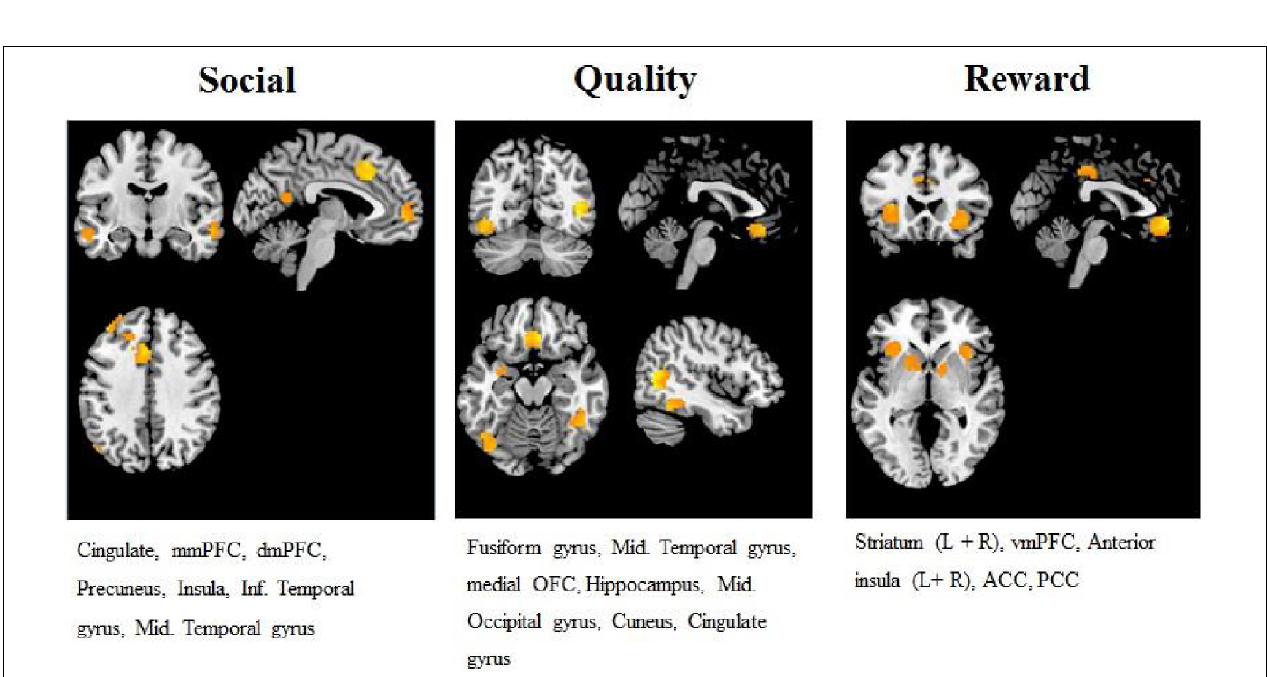
FIGURE 3 | Overview of regions of interest (ROIs) masks used in the analyses. The regions that are included per mask are listed below the mask. The specific ROIs per mask are the yellow/orange areas.